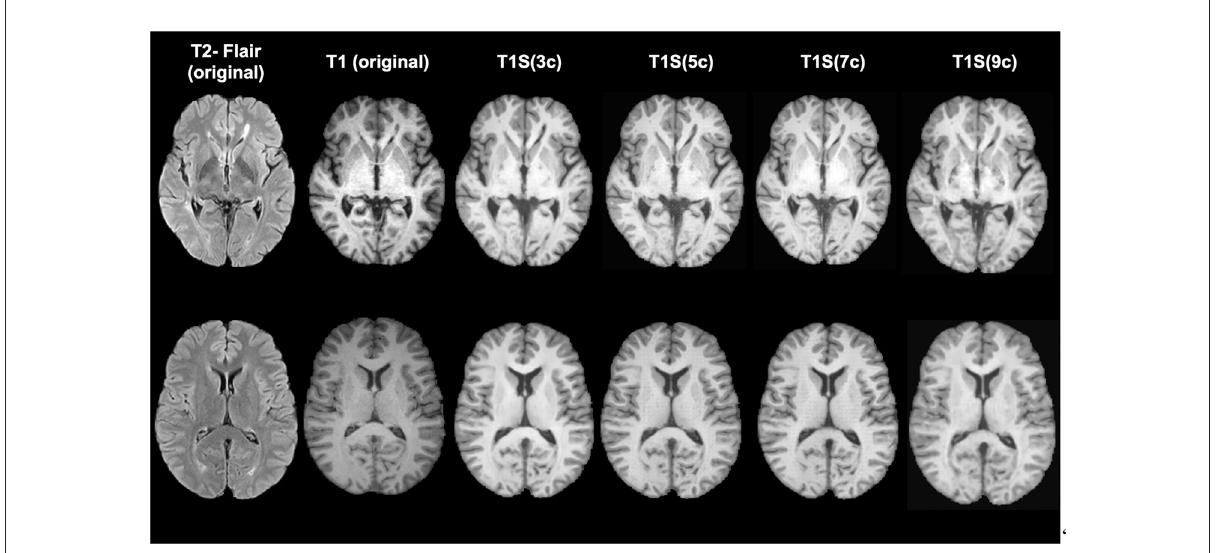
FIGURE4 Examples of original and synthetically obtained images. The first column shows the original T2-FLAIR image, while the second column shows the original T1-w image. The following columns show the T1-w images obtained from the T2-FLAIR image using a different number of clusters (3, 5, 7, and